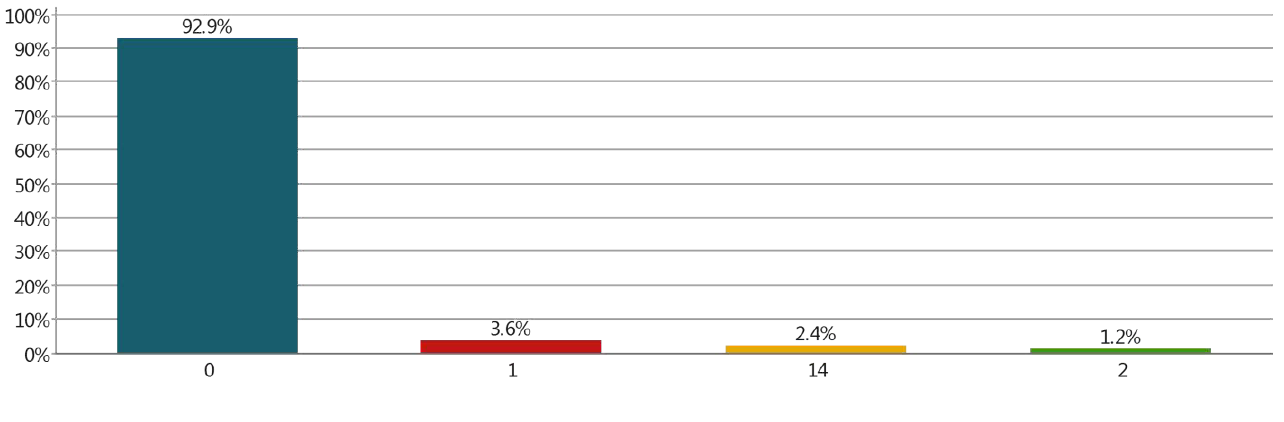
Figure 14. Data application